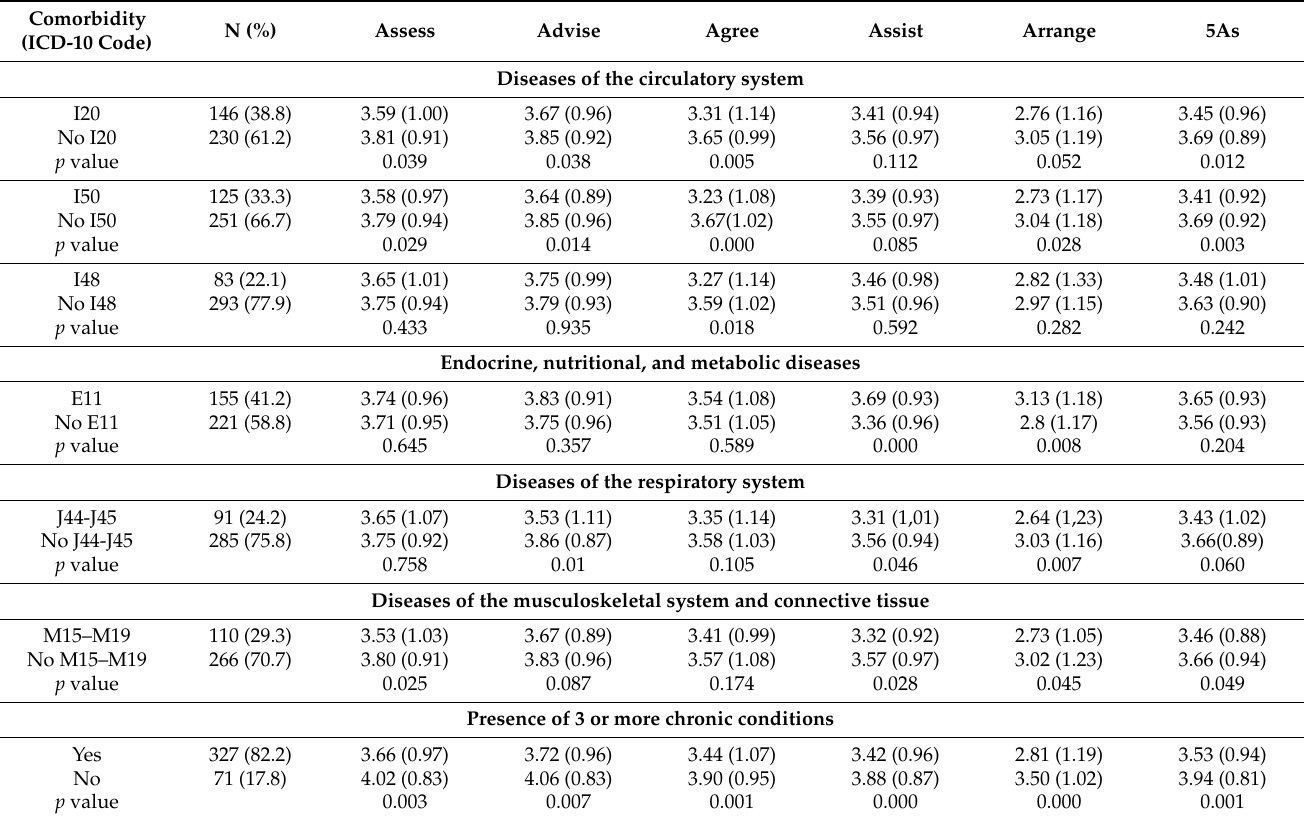
Table 7. The comparison of PACIC+ score by the presence or absence of comorbidity. Data are presented as mean (standard